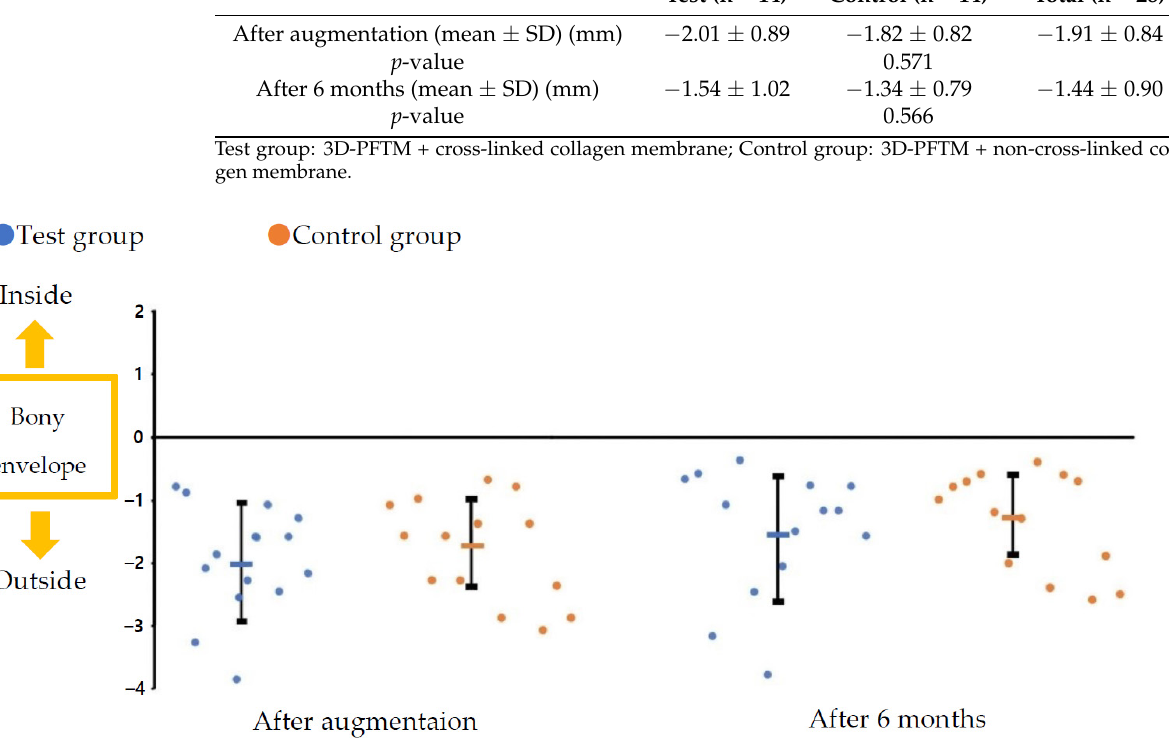
Figure 5. Distance from the boundary line of the bony envelope to the hard tissue profile immediately after augmentation and after 6 months of healing.